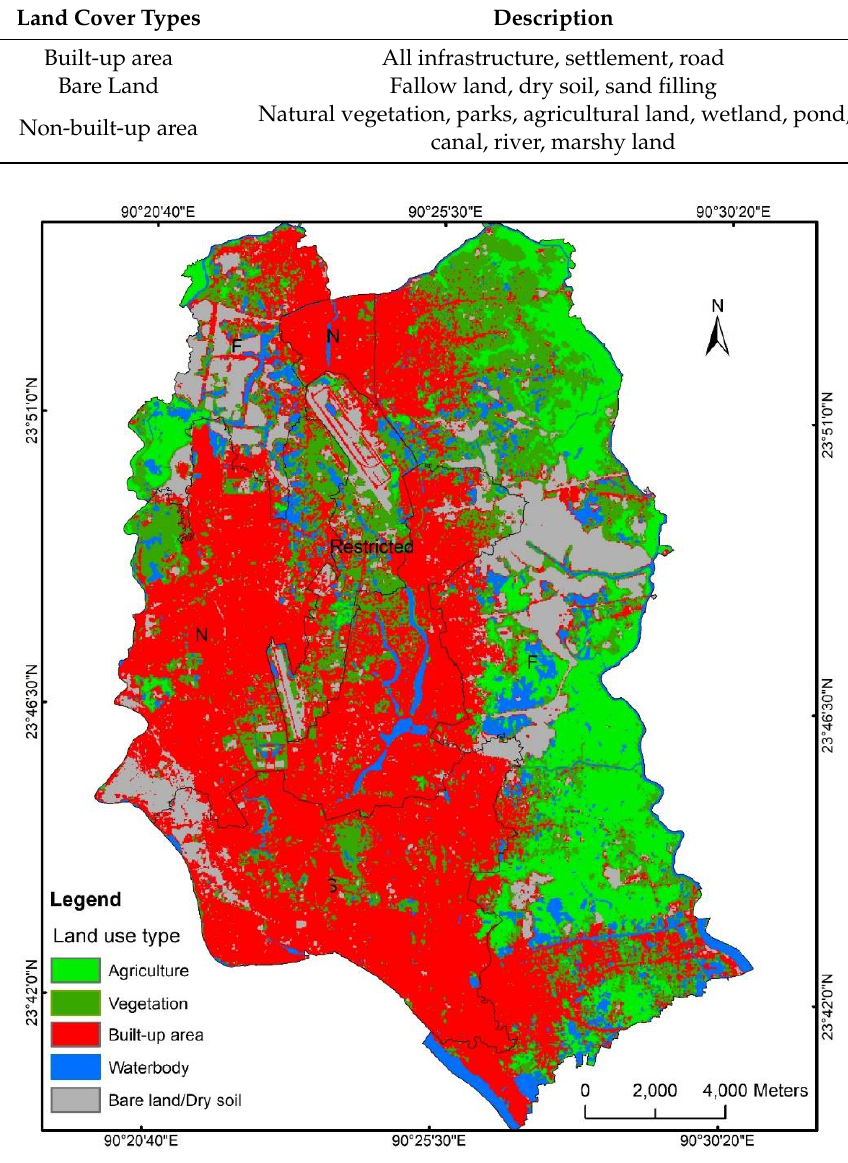
Figure 6. Land use land cover (LULC) map for the year of 2013, in map N, S, and F refer to Dhaka North City Corporation (DNCC), Dhaka South City Corporation (DSCC), and fringe area, respectively.